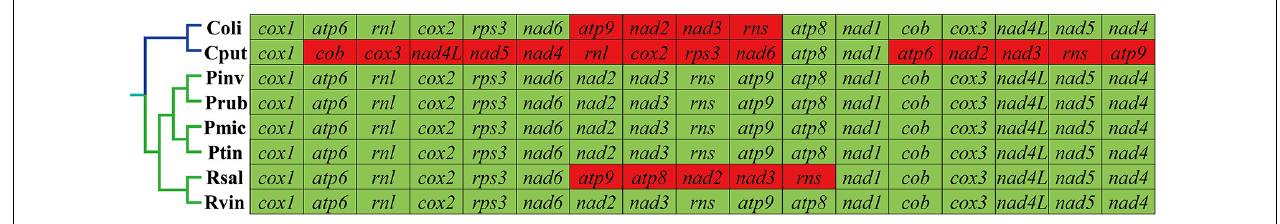
FIGURE 3 | Mitochondrial gene arrangement analyses of eight Boletales species. All genes are shown in order of occurrence in the mitochondrial genome, starting from cox1 . Fifteen core protein coding genes and two rRNA genes were included in the gene arrangement analysis. Genes with a green background indicate that they are conservative in Boletales species. The genes with red background indicate that they have gene rearrangements. The phylogenetic positions of the eight Boletales species were established using the Bayesian inference (BI) method and Maximum Likelihood (ML) method based on concatenated mitochondrial genes. Coli, C. olivacea ; Cput, C. puteana ; Pinv, P. involutus ; Prub, P. rubicundulus ; Pmic, P. microcarpus ; Ptin, P. tinctorius ; Rsal, R. salebrosus ; Rvin, R. vinicolor .